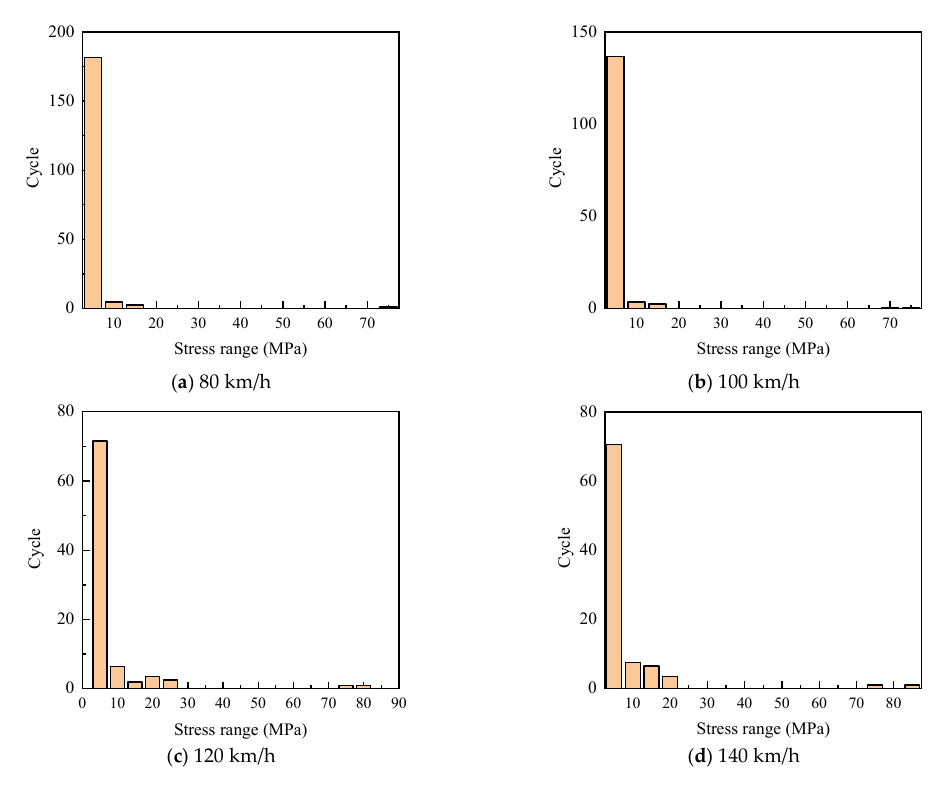
Figure 7. Stress range of steel rebar of 30 m-span bridge.